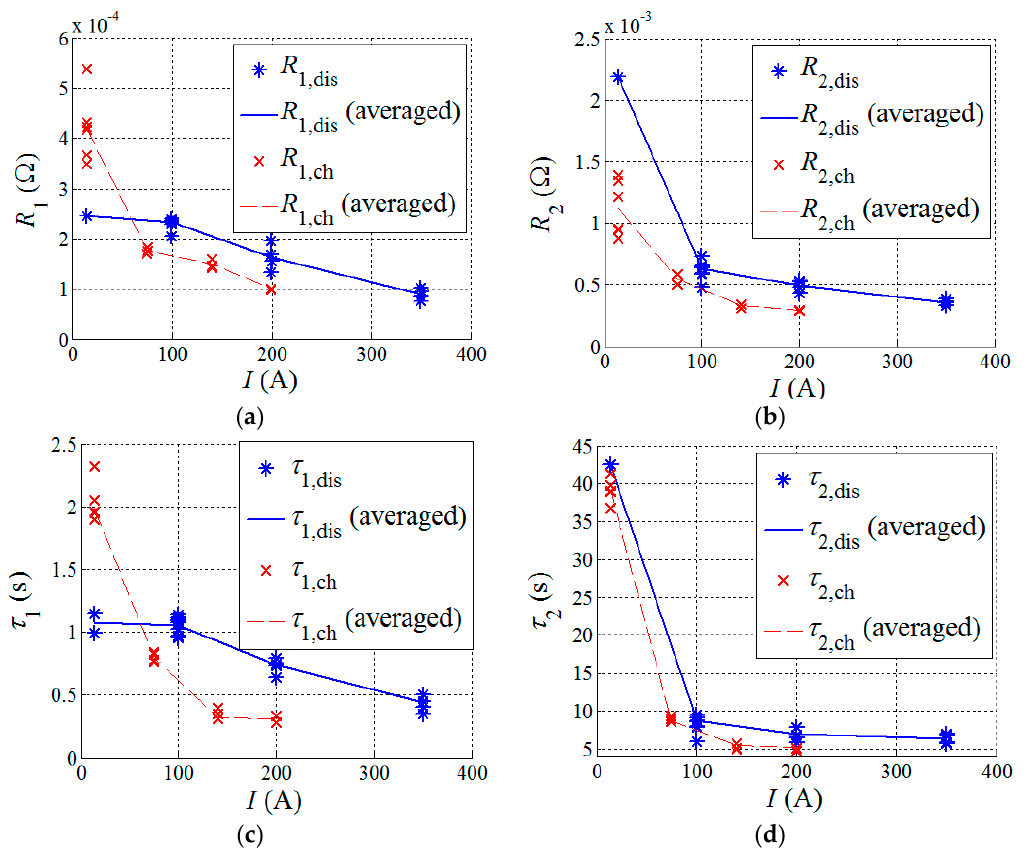
1 ; ( b ) R 2 ; ( c ) τ 1 , and ( d ) τ 2 .